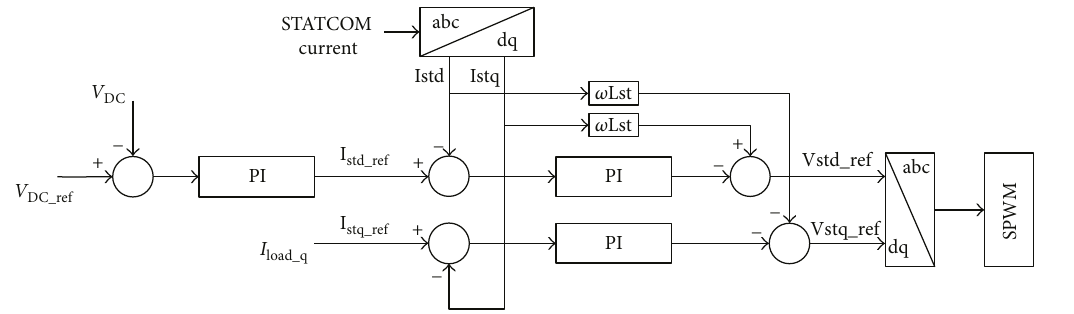
Figure 4: General block diagram of an indirect current controller.